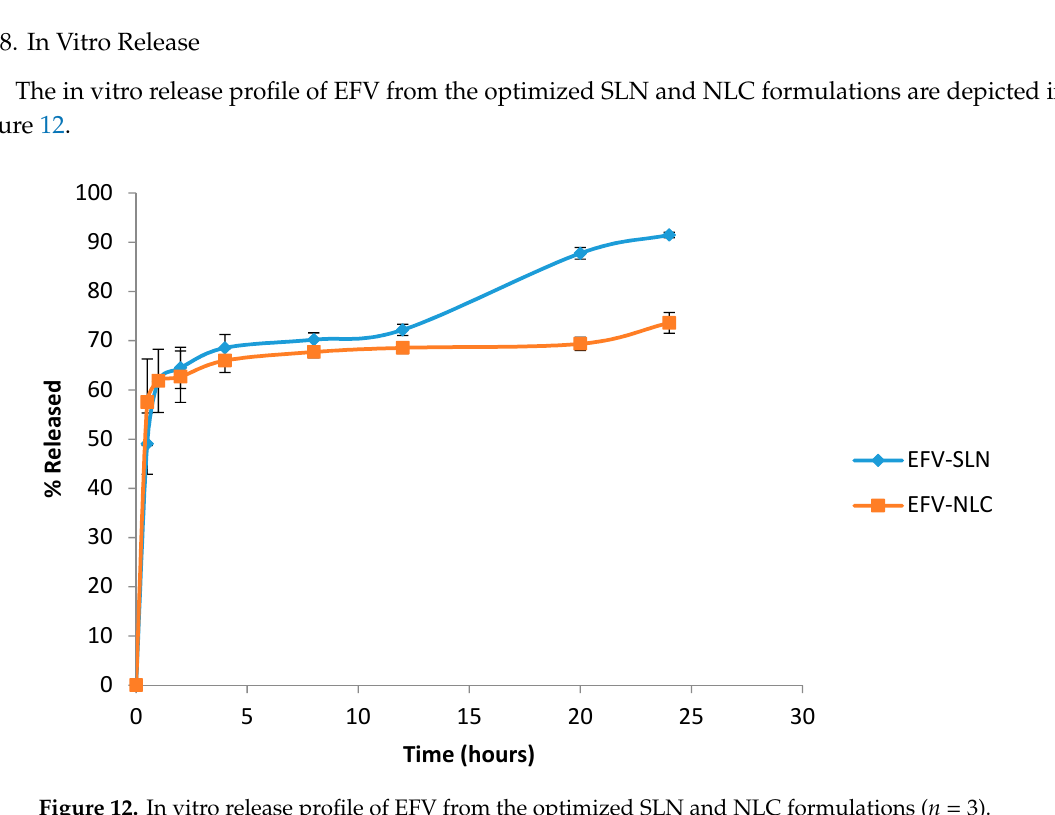
Figure 12. In vitro release profile of EFV from the optimized SLN and NLC formulations ( n = 3).